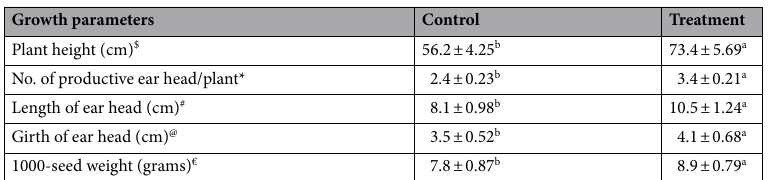
Table 3. Effect of seed treatment with T. asperellum (DL-81) on pearl millet growth parameters under field conditions. Values ± SE (standard error) are means of three independent replicates; Means followed by the same letter(s) within the row are not significantly different according to Tukey’s HSD at P ≤ 0.05 levels. $ As measured from the base to the tip of the plant. *Number of earheads produced by the main axis and the basal tillers of the plant. # As measured from the base to the tip of the earhead. @ Measured as the circumference of the earhead at the centre. € Calculated by weighing 1000 seed in five